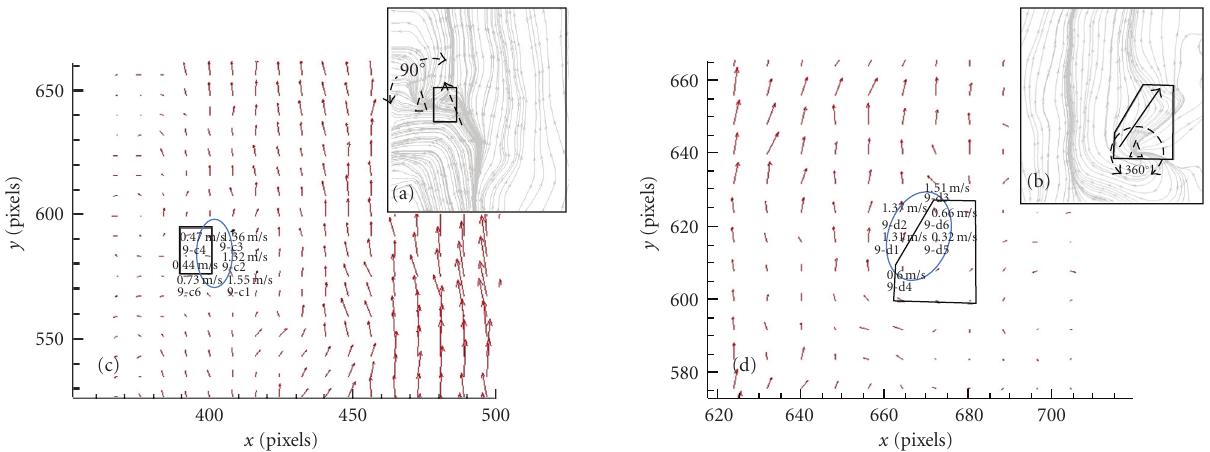
Figure 9: (a) and (b) Streamlines passing through the left (a) and right (b) flame edges of case 6. (c) Velocity variation at the left flame edge of case 6. The points’ velocities in the polygon are 0.76 m/s, 0.47 m/s, 0.17 m/s, 0.44 m/s, 0.54 m/s, and 0.73 m/s (ordered by left to right, top down). The velocities of 9-c1, 9-c2, and 9-c3 are 1.55m/s, 1.32 m/s, and 1.36 m/s. (d) Velocity variation at the right flame edge of case 6. The points’ velocities in the polygon speeds are 0.66 m/s, 0.37m/s, 0.32m/s, 0.41 m/s, 0.6 m/s, 0.54 m/s, 0.53 m/s, 0.69m/s, 0.33 m/s, and 0.23m/s (ordered by left to right, top down). The velocities of points 9-d1, 9-d2, and 9-d3 are 1.31 m/s, 1.37m/s, and 1.51